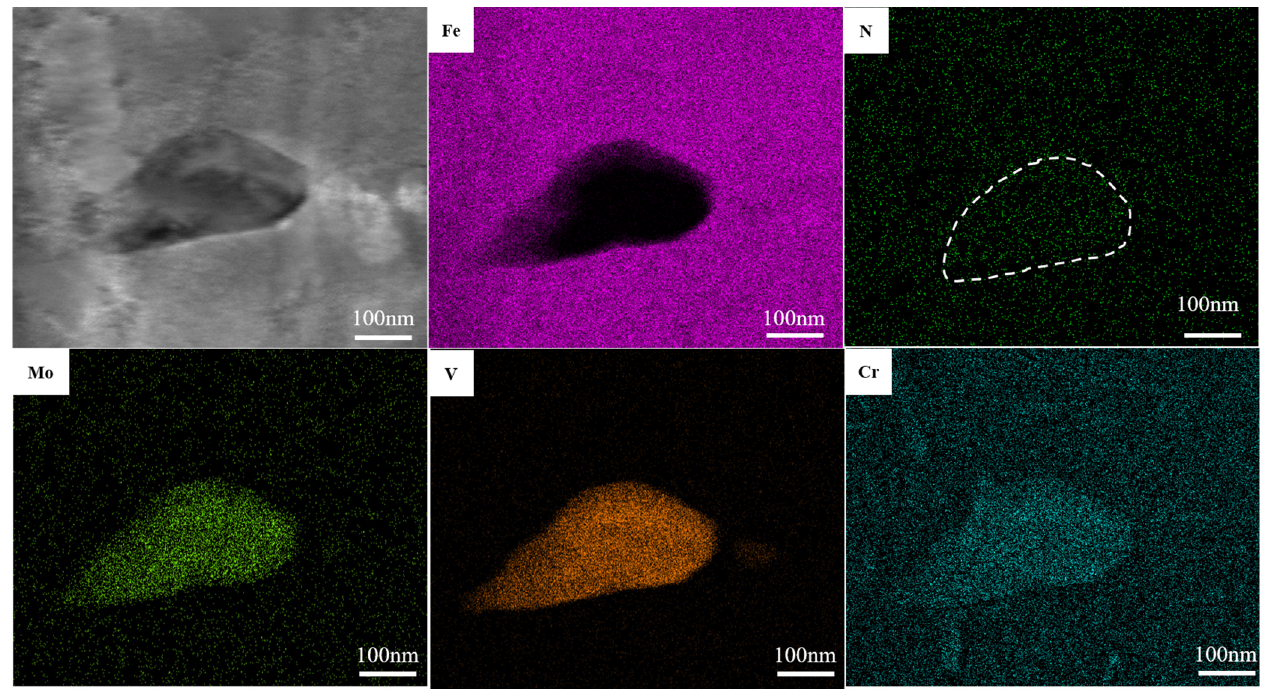
Figure 5. TEM image of nitride and corresponding EDS maps.